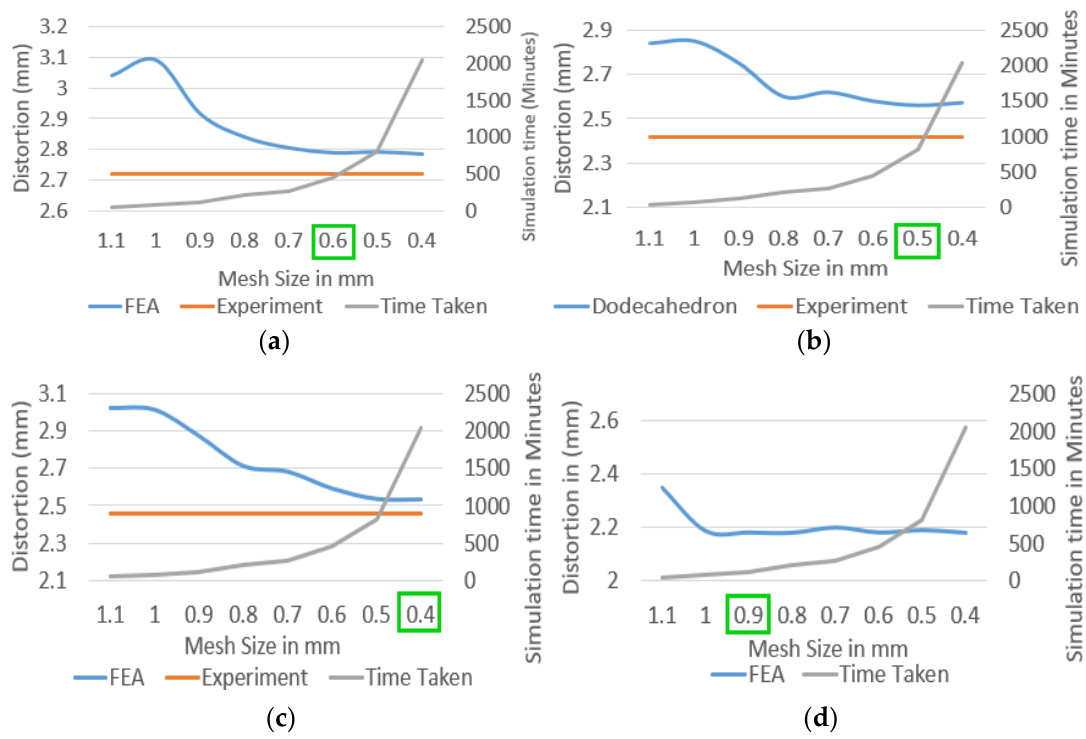
Figure 16. AM simulation mesh sensitivity analysis on the cantilever test model with: ( a ) BCC support; ( b ) dodecahedron support; ( c ) perforated block support; ( d ) homogenized CAD support.